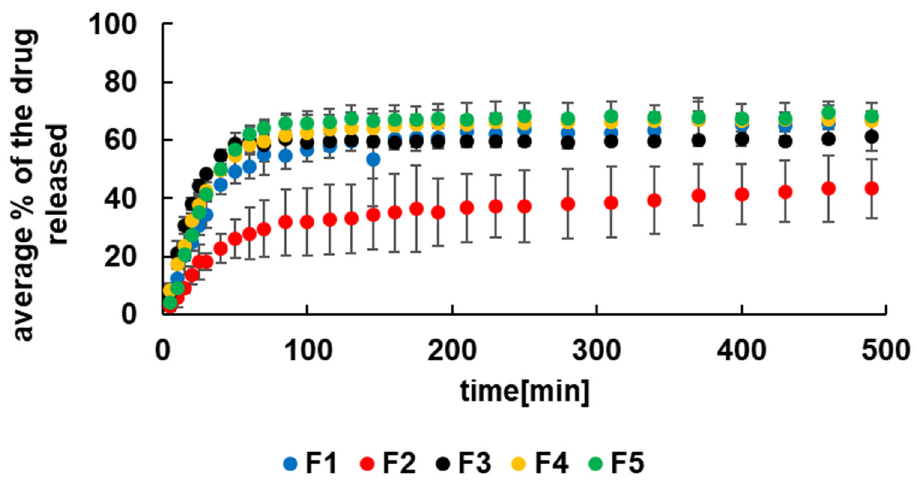
Figure 5. The release curves of 5-ASA from formulations F1–F5 to pH = 7.4 buffer with